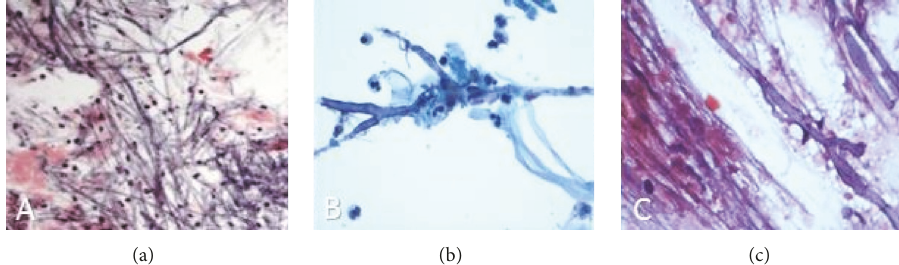
Figure 4: (a) PAS stain of the retinochoroidal biopsy demonstrates septate filamentous fungi with acute angle branching consistent with Aspergillus fumigatus . (b) Pap stain of the vitreous fluid shows acute inflammation, fibrin, and true septate hyphae with 45-degree branching. (c) Hematoxylin and eosin-stained squash preparation from the brain lesion demonstrates true hyphae with 45-degree branching in a background of necrotic